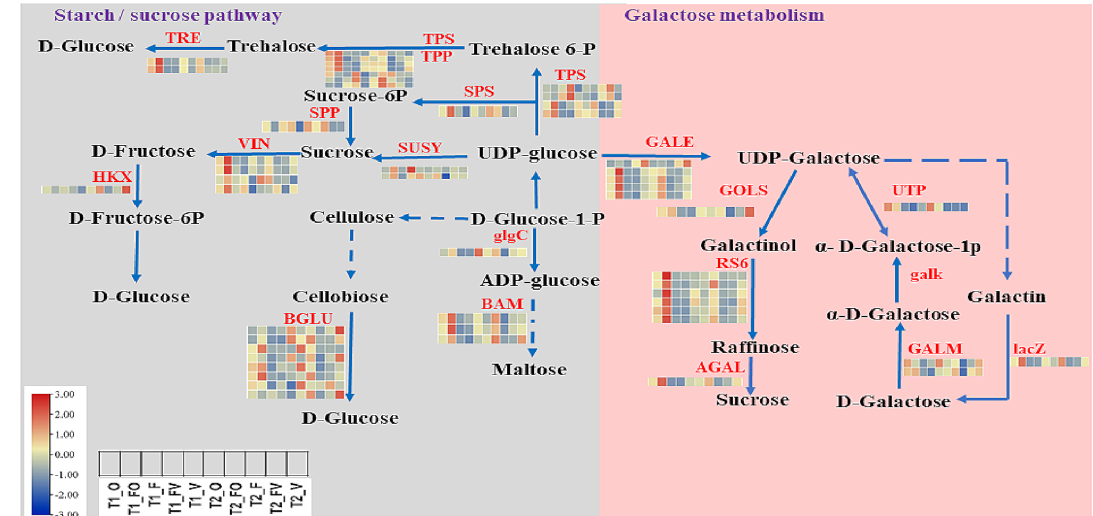
Figure 5. Diagram chart of two carbohydrate metabolism-related pathways for hybrid overdominance genes in the root of rapeseed and their expression. Starch/sucrose and galactose metabolism pathways. The expression pro- file of DEGs is showed in heatmaps according to counts of the normalized feature (log2 (1 + counts)) using the depth red color represented the up − regulated gene expression and blue represented the down − regulated gene ex- pression. SUSY: Sucrose synthase; SPP: Sucrose phosphate phosphatase; SPS: Sucrose phosphate synthase; VIN; Vacuolar invertase; HKX: Hexokinase; TPS: Trehalose 6 − phosphate synthase; TPP: Trehalose 6 − phosphate phos- phatase; TRE: Trehalase; BGLU: Beta − glucosidase; BAM: Beta − amylase; glgC: Glucose − 1 − phosphate adenylyltrans- ferase; GALE: UDP − glucose 4 − epimerase; UTP: Alpha − D − galactose − 1 − phosphate uridylyltransferase; GOLS: Inositol 3 − alpha − galactosyltransferase; LacZ: Beta − galactosidase; RS6: Raffinose synthase 6; AGAL: Alpha − galactosidase; galK: Galactokinase; GALM: Aldose 1 − epimerase. T1: 21DAS; T2: 24